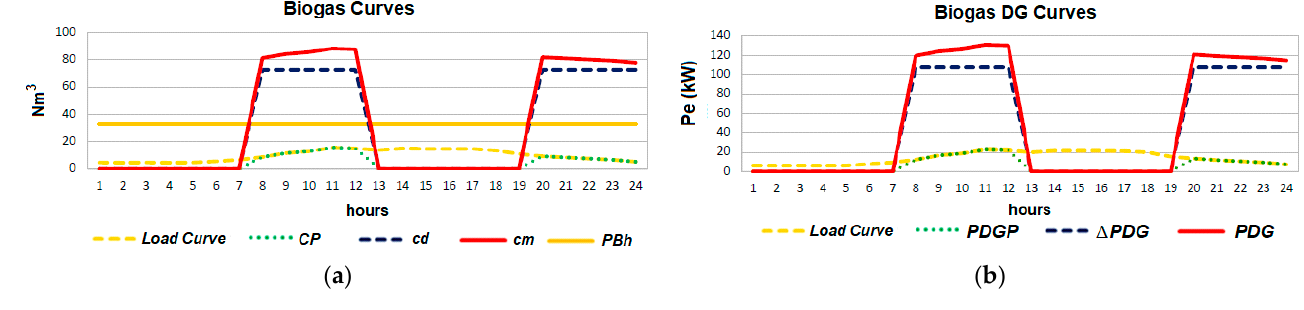
Figure 16. Case 7: ( a ) Biogas curves; ( b ) MOR from biogas DG.